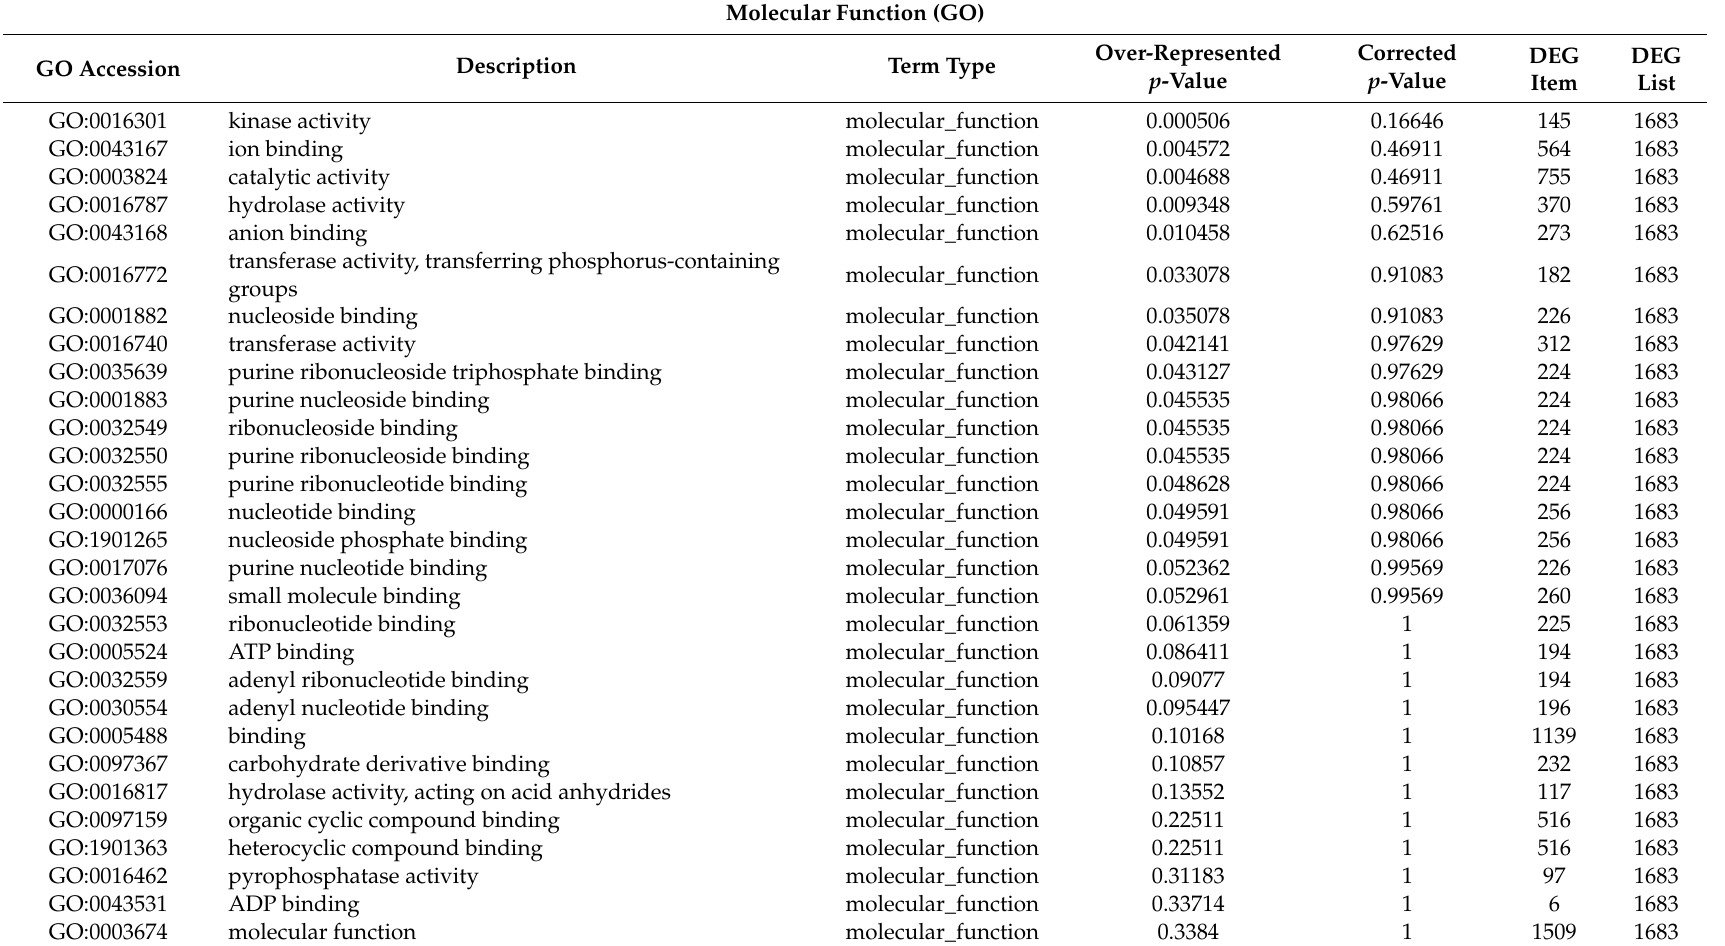
Table 5. Results of the gene ontology (GO) annotation